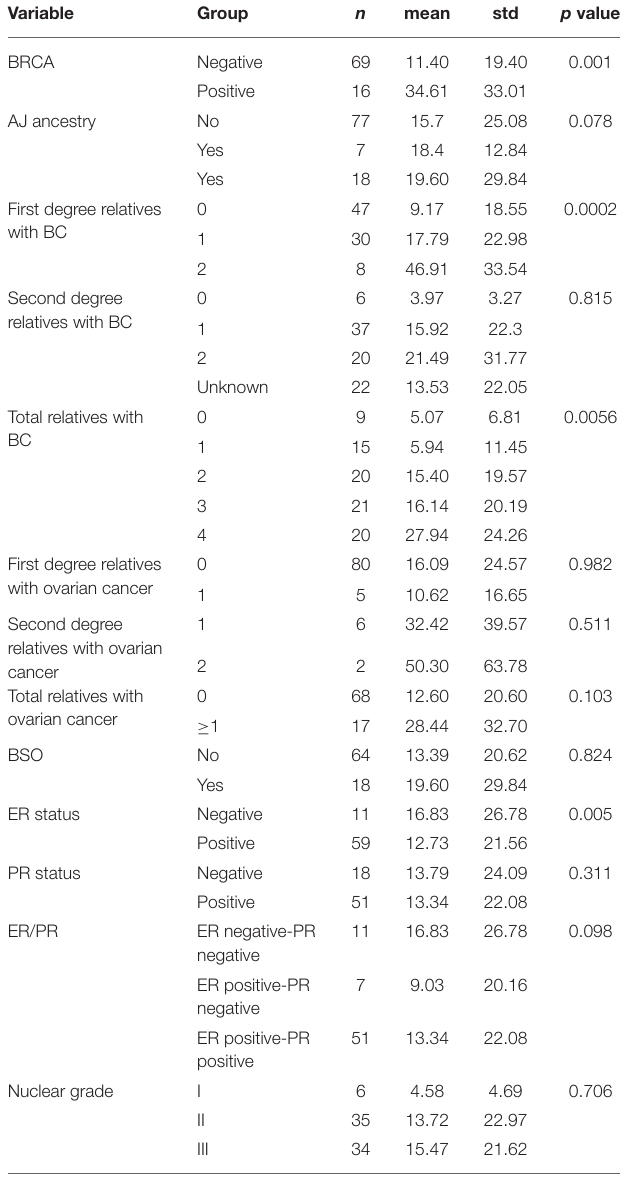
TABLE 2 | Comparisons of BRCAPRO at age of diagnosis by patient’s characteristics.